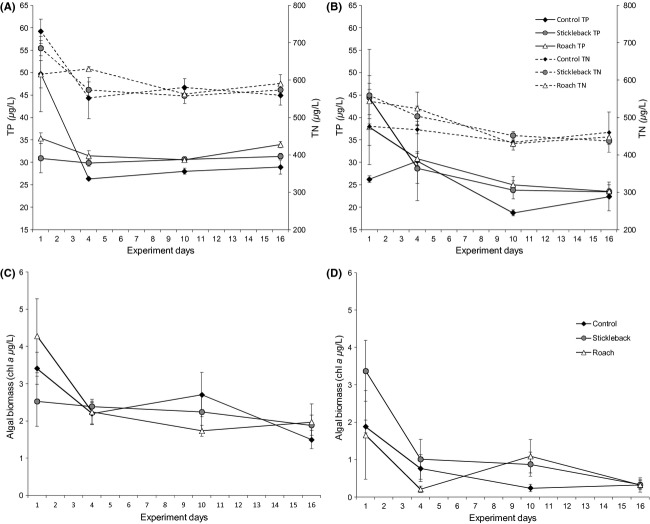
Nutrient concentrations (total phosphorus [―] and total nitrogen [---]) in each enclosure in spring (A) and summer (B) experiments, and algal biomass (measured as chl a) in each enclosure in spring (C) and summer (D) experiments. Error bars are ± SE. Correction added on 28 April 2015, after first publication: The legend and axis titles ‘TN’ and ‘TP’ were previously indicated wrongly as “NT” and “PT” and have now been corrected in this version.